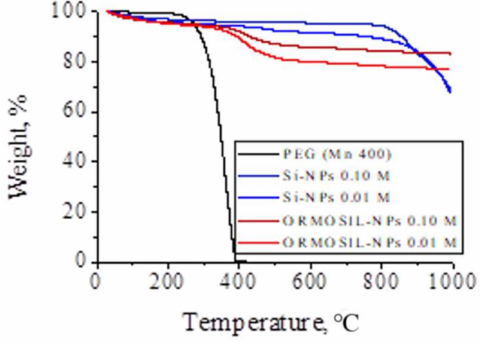
Figure 6. Mass percent versus temperature thermogram of PEG (Mn 400), Si-NPs and